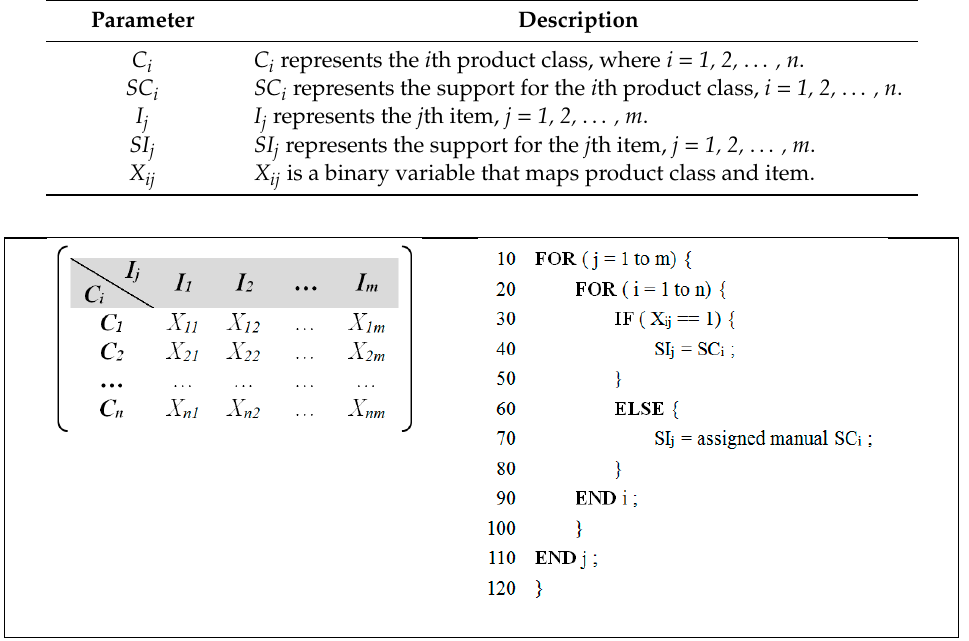
Table 2. Parameter definition of “classification of items (COI)”.